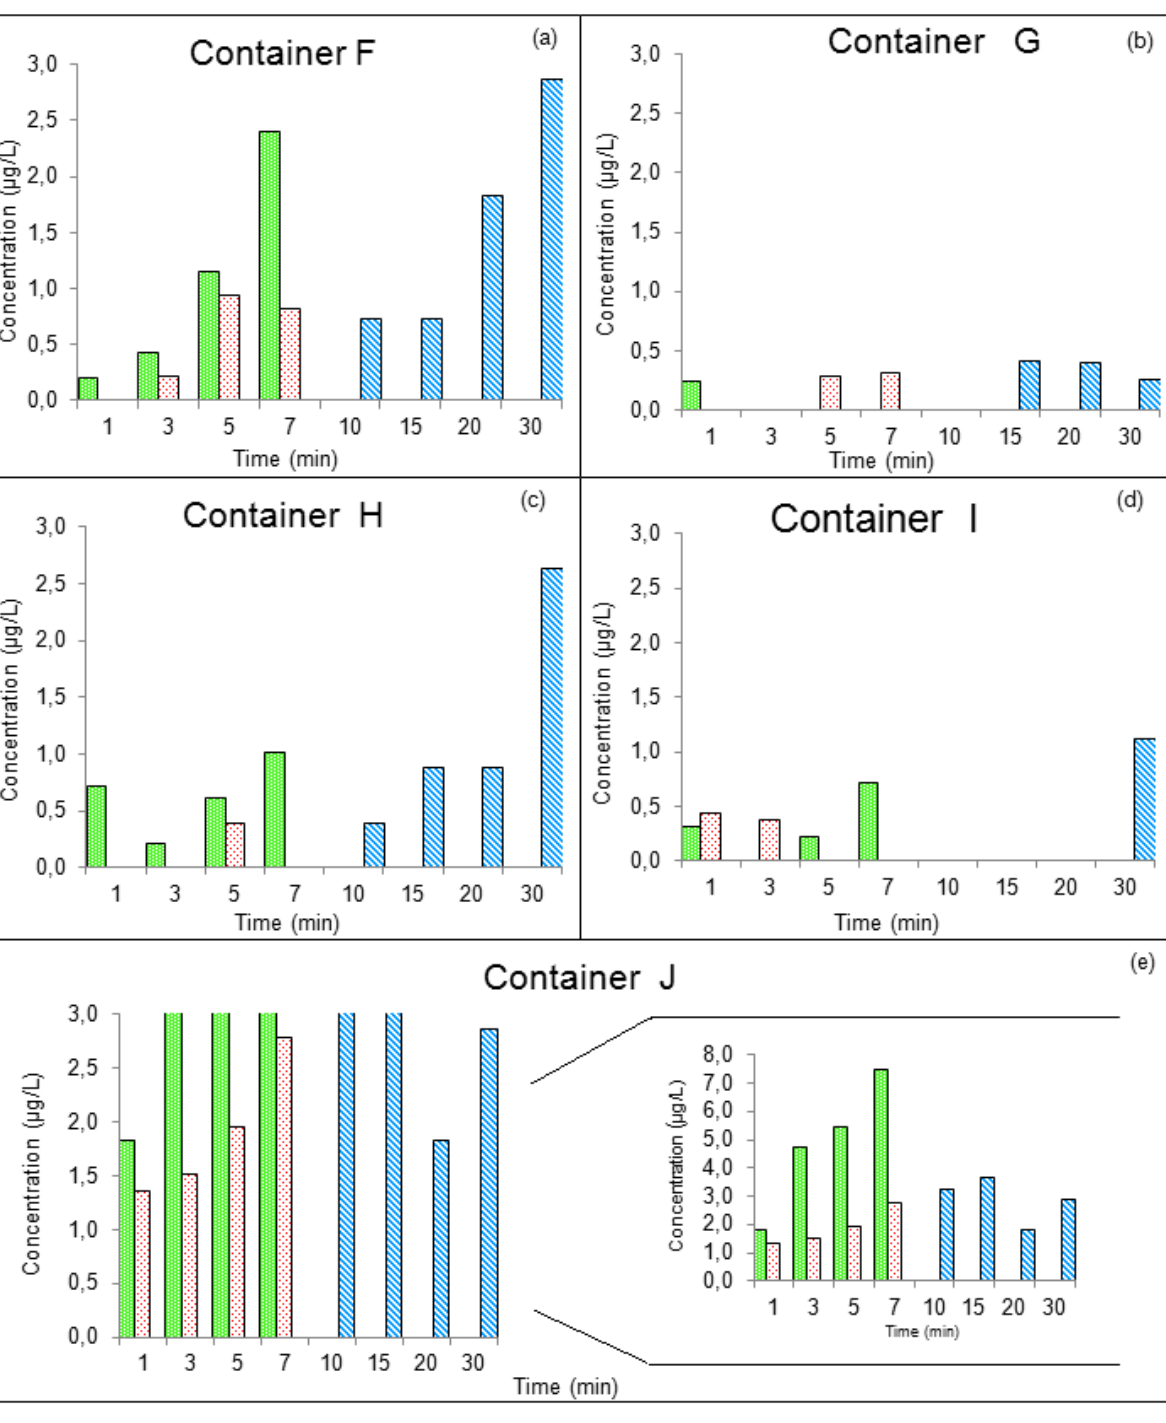
Figure 4. Migrated DBP concentrations in the Group II food simulant containers ( a ) container F, ( b ) Container G, ( c ) Container H, ( d ) Container I, and ( e ) Container